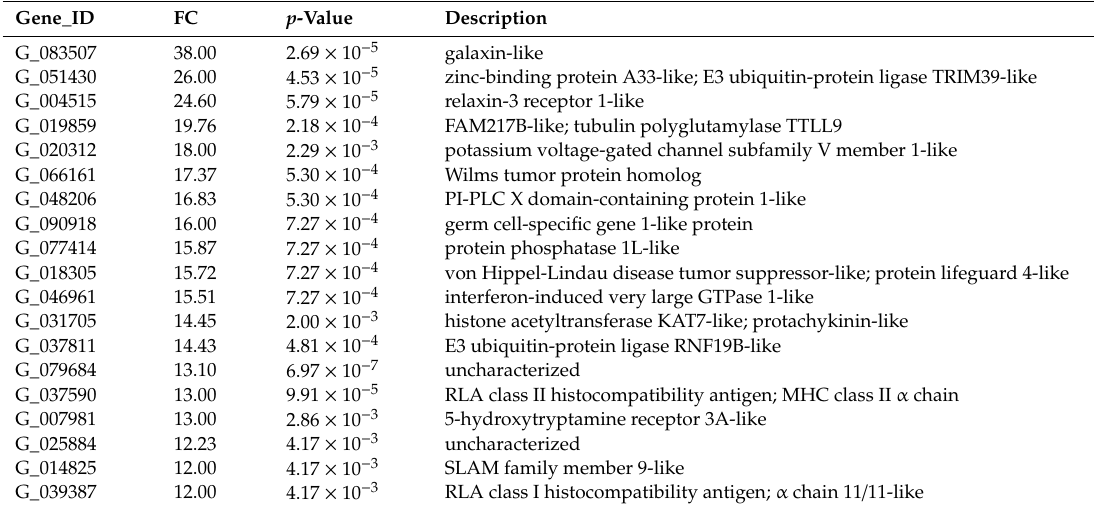
Table 1. Up-regulated di ff erential expression (DE) genes in TM compared to